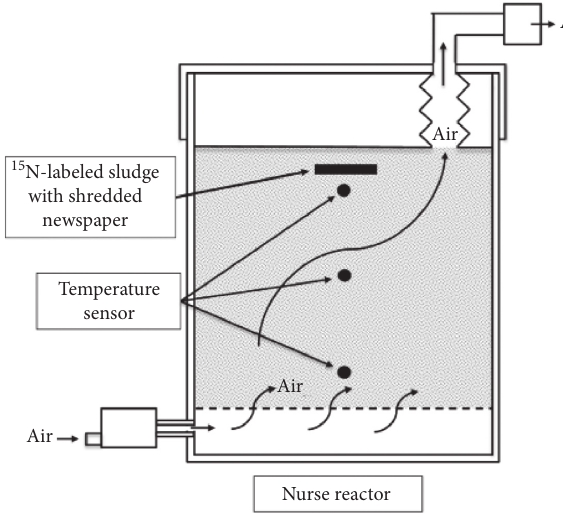
Figure 2: The nurse reactor for preparing the 15 N-SF-PM. Waste sludge of 170kg that came from a bean curd factory was mixed with 30kg of shredded newspaper and placed in a box reactor (60 cm l × 60cm b × 120cm h). The composting reaction starts by aeration with warmed air at around 35 ° C, and 3 ∼ 5 days after the start of aeration when the temperature reached around 40 ∼ 50 ° C, the sandwiched 15 N-WS-PM was placed horizontally at the area marked with a black bar at 10cm below the top of the WS-PM. Right after the insertion of the sandwich, the aeration was restarted (for details, see Section